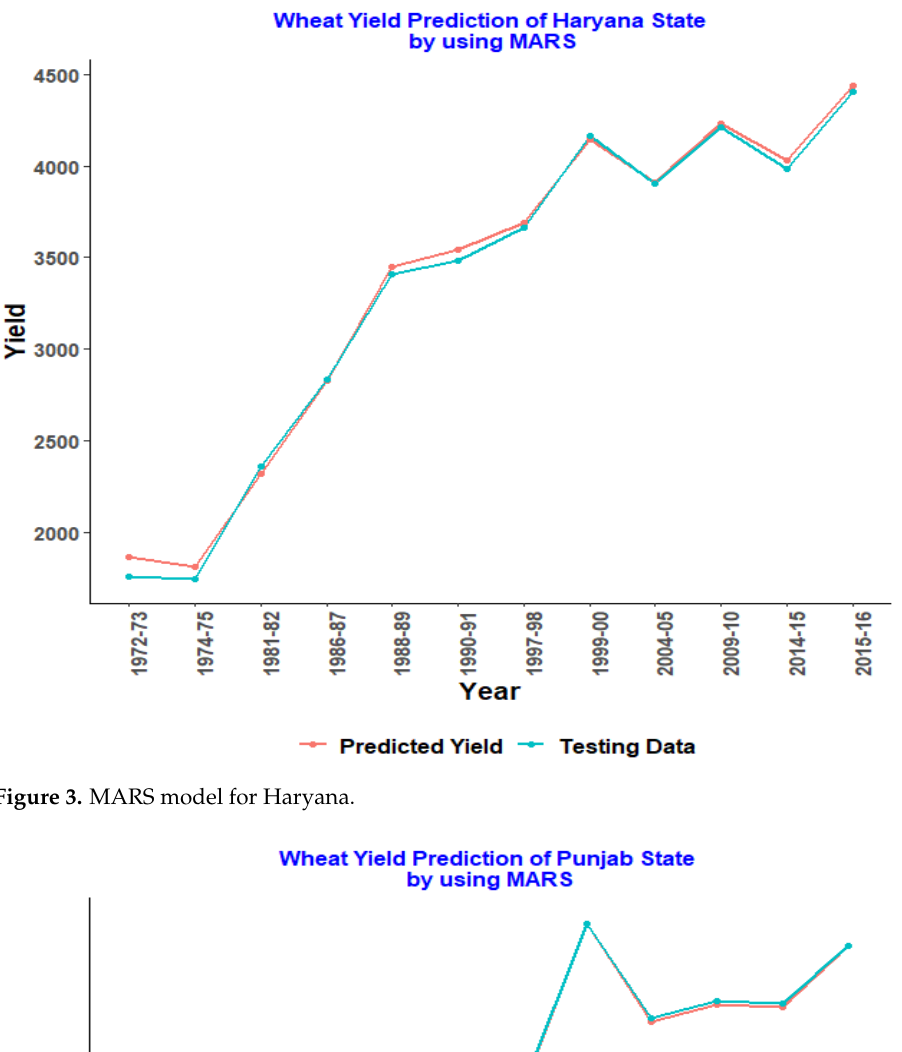
Figure 3. MARS model for Haryana.